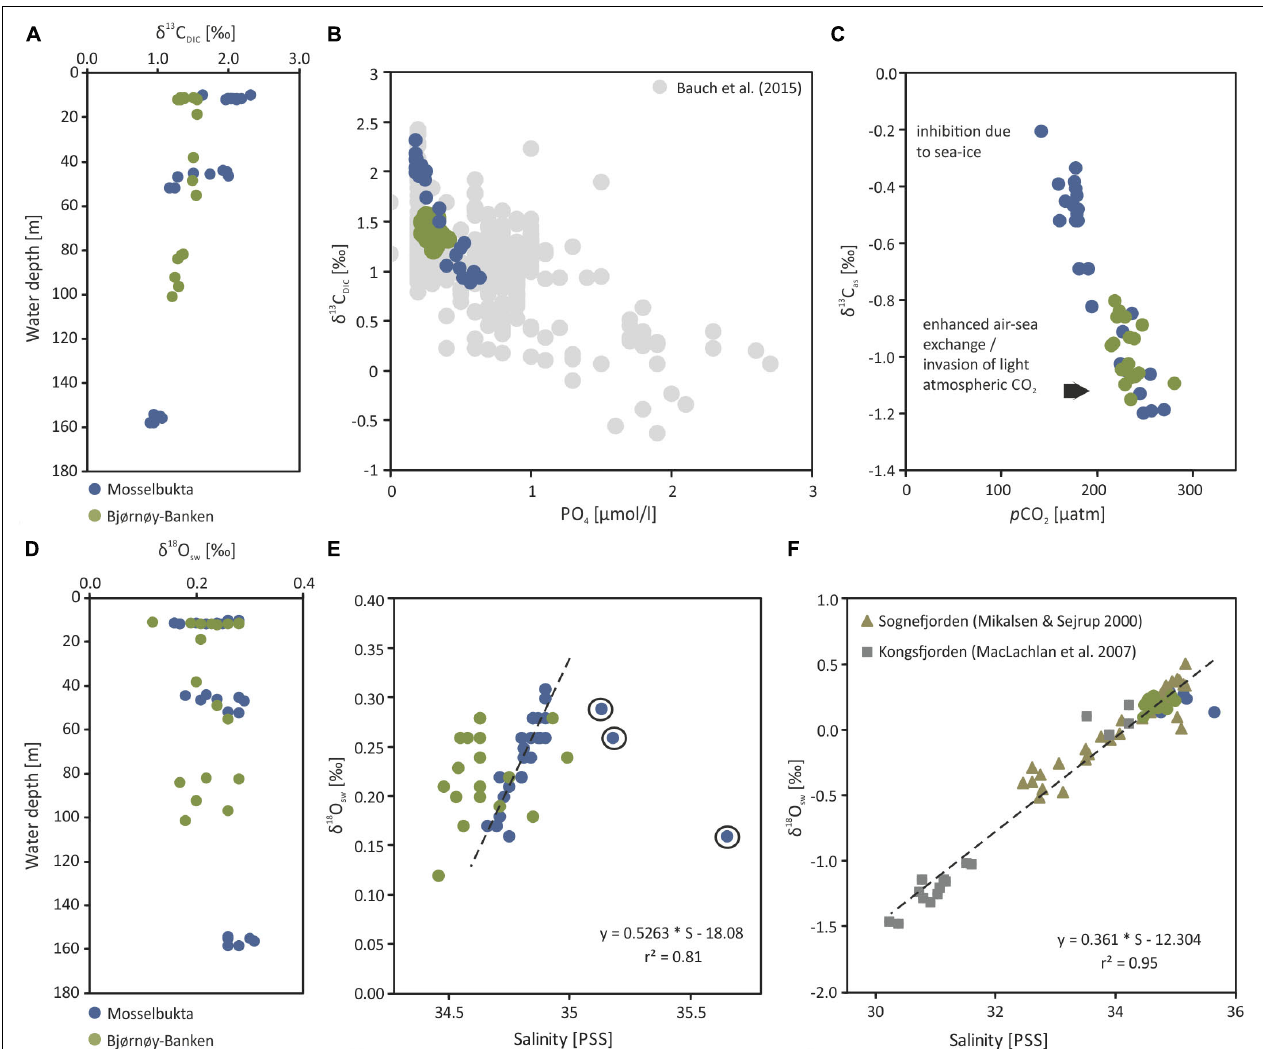
FIGURE 10 | Stable carbon and oxygen isotopes of dissolved inorganic carbon in seawater samples taken from Mosselbukta and Bjørnøy-Banken. (A) δ 13 C DIC plotted against water depth. (B) δ 13 C DIC plotted against PO 4 concentrations, including the δ 13 C DIC – PO 4 relationship from various Arctic regions compiled by Bauch et al. (2015). (C) Adjusted δ 13 C as calculated after Lynch-Stieglitz et al. (1995) and plotted against p CO 2 (for details see text). (D) δ 18 O sw plotted against water depth. (E) δ 18 O sw plotted against seawater salinity. (F) Same as E but including the δ 18 O sw - salinity relationships from Kongsfjorden (W Spitsbergen, MacLachlan et al., 2007) and Sognefjorden (W Norway, Mikalsen and Sejrup,